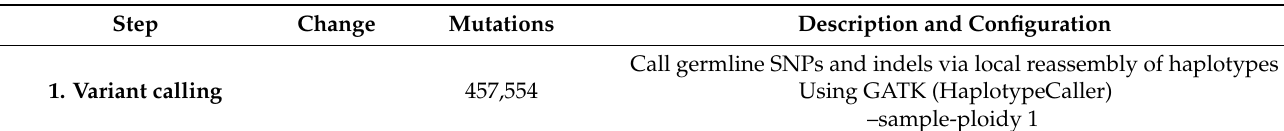
Table 1. Quality control (QC): reduction of some 457,000 raw variants to 206,633 high-quality variants. Filtering the rare variants (based on MAF) is the main